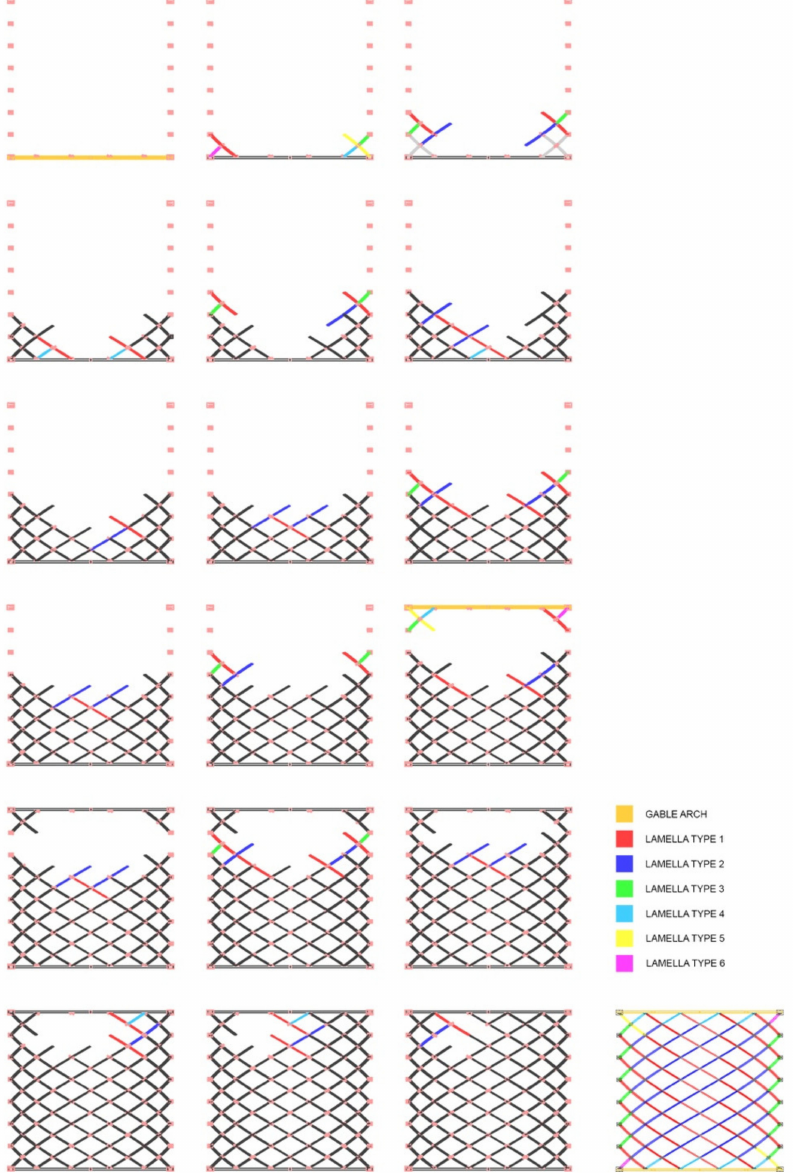
Figure 13. A diagram of the construction process of the physical model. The base arches for the lamellae were delivered to the building site where they were measured and bevelled according to the specifications. During the construction, it was concluded that the base arches tended to elongate because of high temperatures, so the position of the joints had to be measured according to the triangle between the edge joints and the middle one. The joints were mounted onto the middle of each lamella on the ground. The lamellae would be then placed at the designed position in the structure and controlled by the position of the stings marking the height of the nodes. The